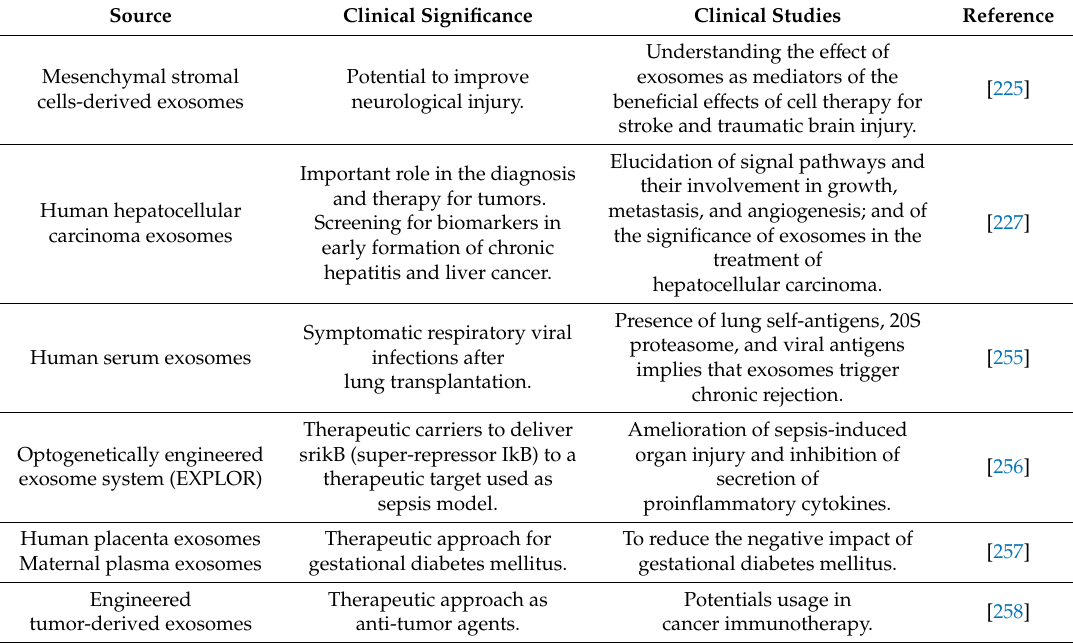
Table 1. A number of publications related to the potential use of exosomes obtained from liquid biopsy or cultured cells, and their cargo contents in diagnosis, prognosis, and